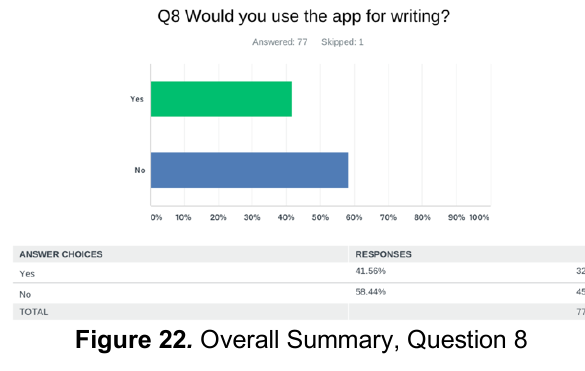
Figure 22 . Overall Summary, Question 8